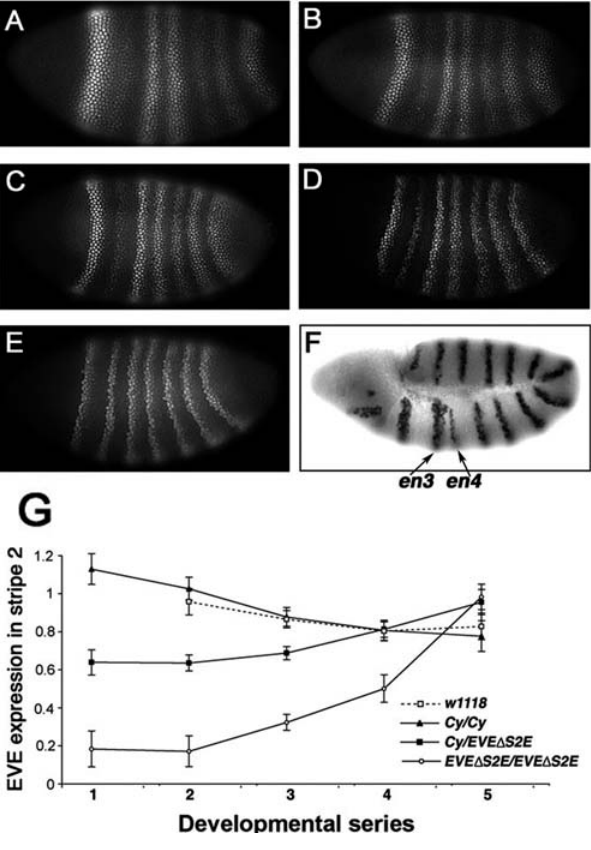
Figure 3. Developmental Series of EVE Abundance (A–E) Immunofluorescence labeling of time-staged early EVE D S2E homozygous embryos. This developmental sequence, which corre- sponds roughly from the initialization of cellularization (A) to its com- pletion (E), takes approximately 45 min at 25 o C in wild-type flies [41]. (F) Expression of en in same genotype at stage 10. Arrows mark third and fourth en stripes. Note the short interval between en stripes 3 and 4 (parasegment 3) and the reduced fourth stripe. (G) EVE expression in stripe 2 during the developmental series around cellularization, where times 1–5 correspond to pictures in A– E. Stage 1 is early cellularization, while the process has been completed for embryos in class 5. The series is comparable to time classes 4–8 on the FlyEx Web site (http://flyex.ams.sunysb.edu/flyex/) [34]. Estimated least square means ( 6 SE) for EVE D S2E/Cy stock and wild-type line w1118; note the Cy/Cy homozygote is essentially wild- type. Early eve pair-rule expression is not known to be autoregulated (as occurs in postcellularization stages), and we observe a 2-fold difference in early stripe expression, with an additive component (a) of 0.62 and negligible dominance deviation (d/a) = 0.01, for the first two stages. This dosage dependency is lost after the cellularization stage (3), presumably because all embryos carry two copies of the autoregulatory element. DOI: 10.1371/journal.pbio.0030093.g003